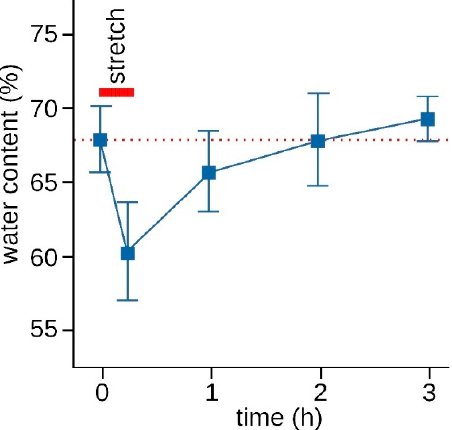
Figure 5. Changes in water content after 15 min of stretching according to Schleip et al. [27]. The figure shows the mean water content of lumbar fascia samples from porcine ( n = 25) after a 15-min stretch of 4%. The error bars show the standard deviation.